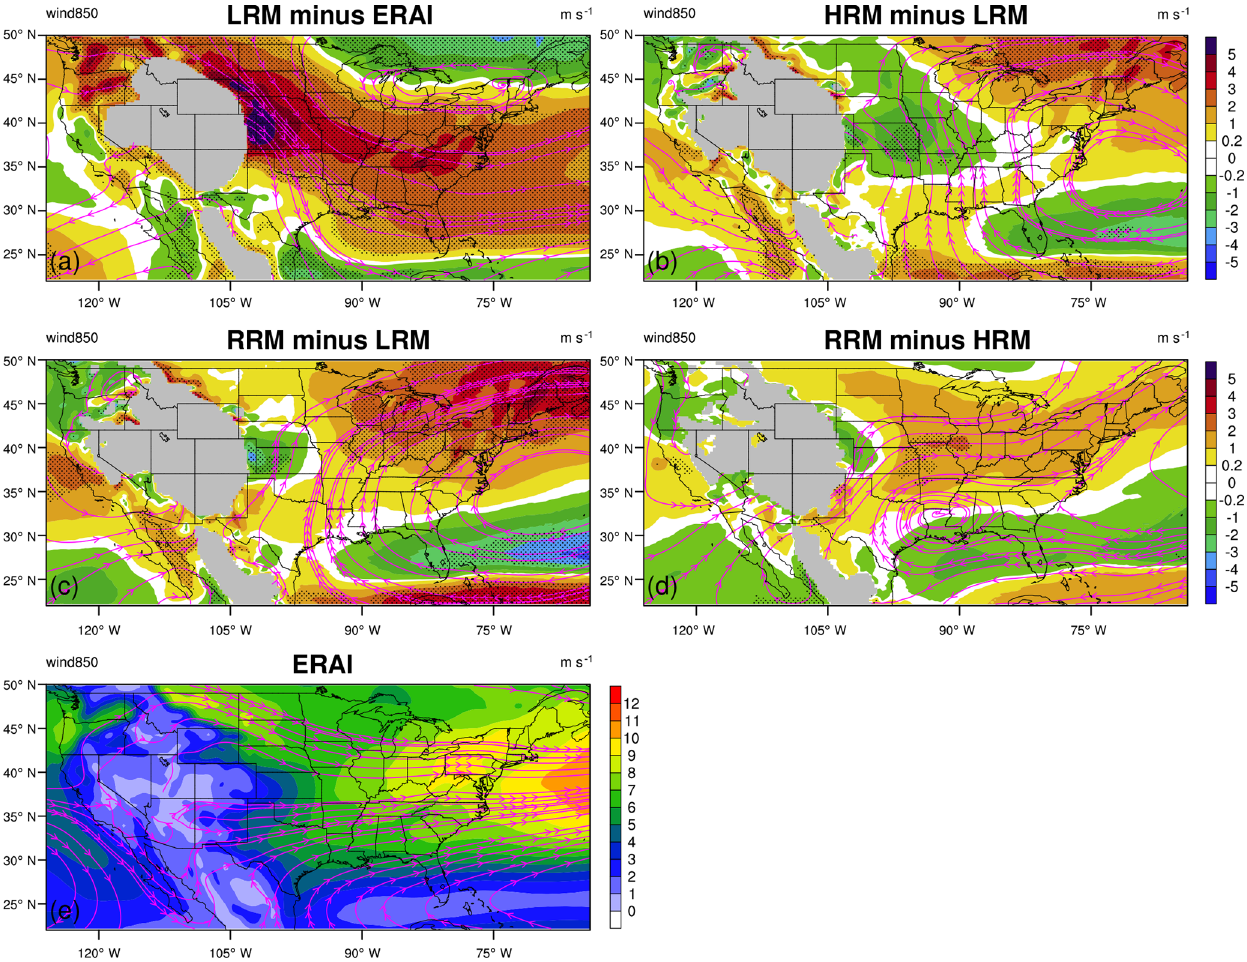
Figure 9. Same as Fig. 8, but for DJF. Note that the color scale is different from that in Fig.